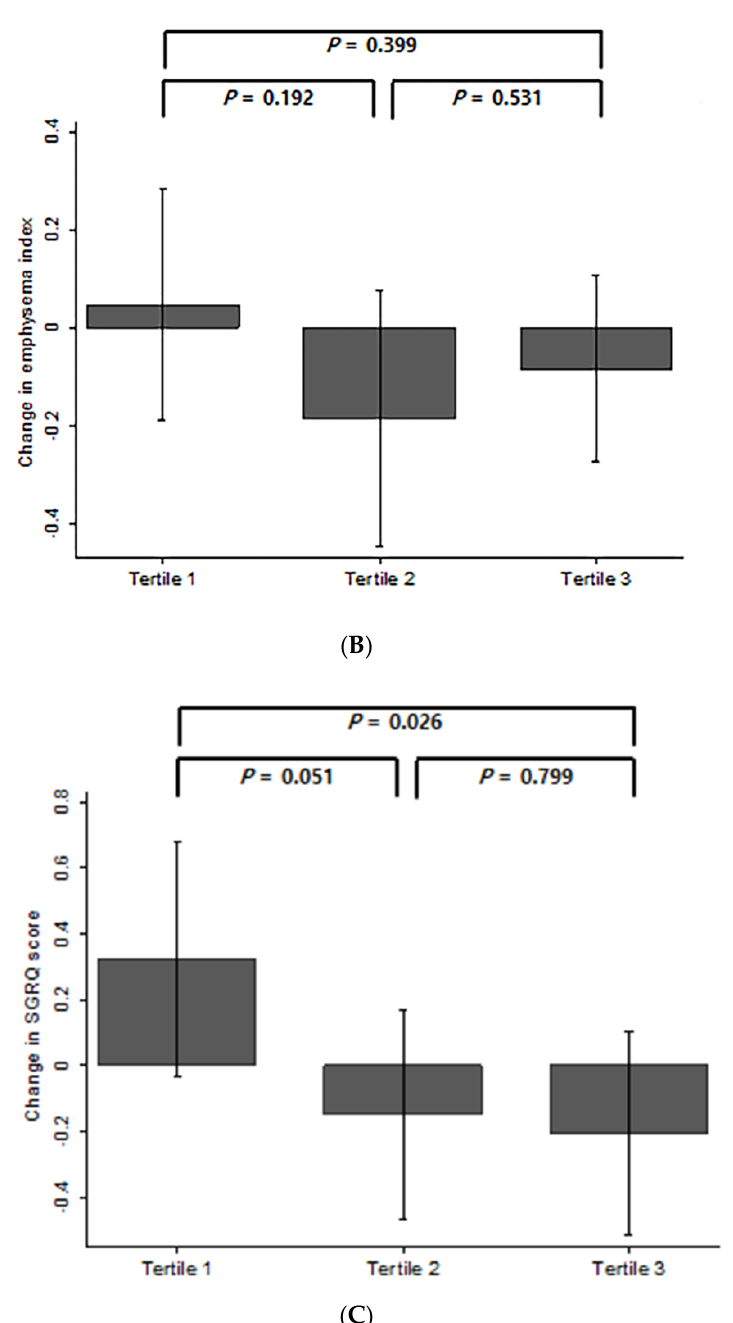
Figure 3. Comparison of annual rates in change of ( A ) post-bronchodilator FEV1, ( B ) emphysema index, and ( C ) SGRQ score by annual rates of decline in Kco. Comparisons of the risk of acute exacerbations and mortality in COPD according to changes in Kco over time.